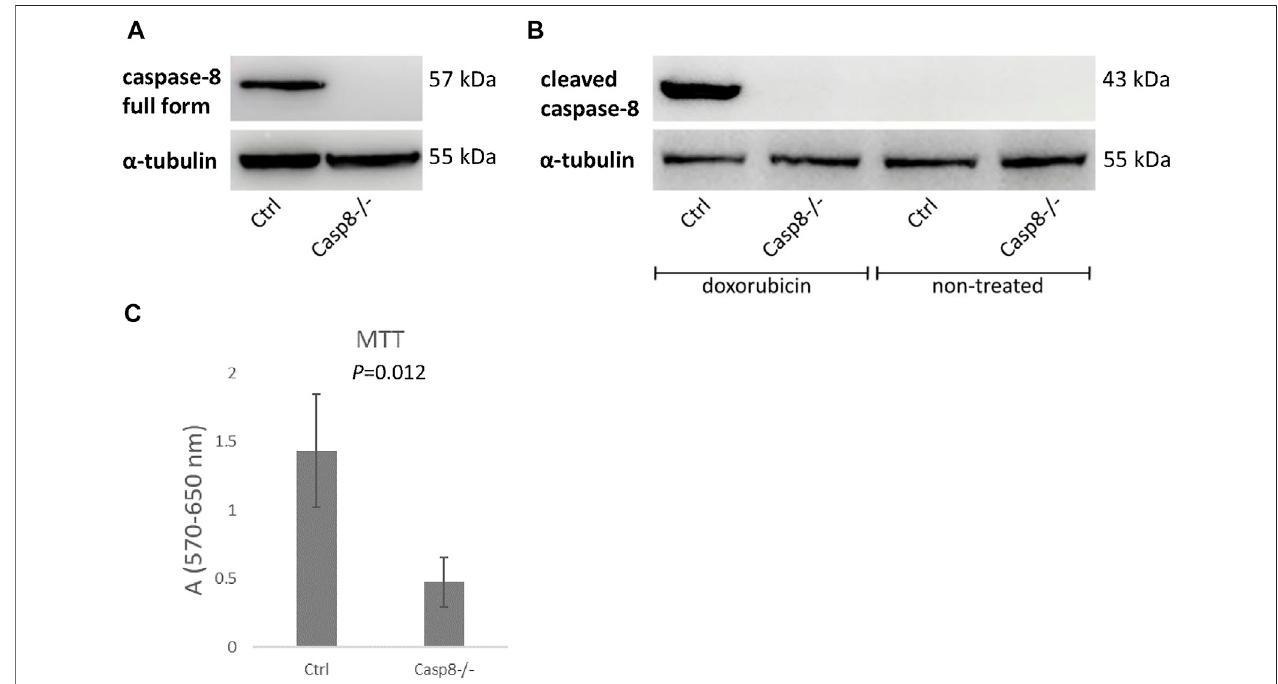
FIGURE 2 | Immunoblotting of full length caspase-8 proenzyme in unstimulated Casp8 − / − and control cells (A) and cleaved caspase-8 in doxorubicin stimulated Casp8 − / − and control cells (B) . Cell proliferation of Casp8 − / − cells compared to control cells evaluated by MTT test (C) .